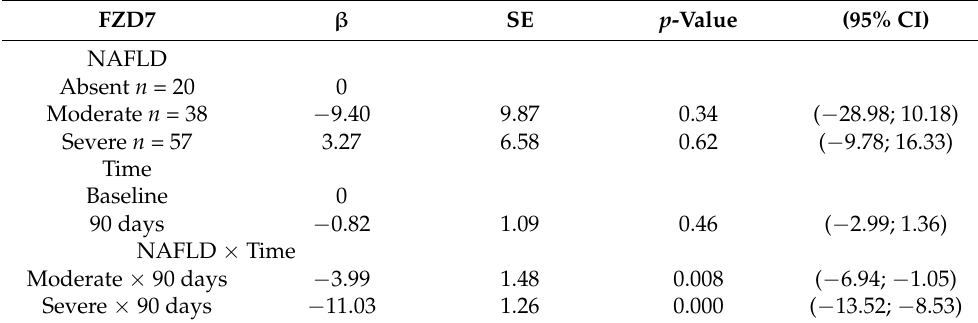
Table 2. Repeated measures analysis of variance. Expected mean FZD7 expression and NAFLD scores (as assessed by CAP value) by time and NAFLD severity. NutriAtt Trial, Castellana Grotte, 2015–2016. Number of healthy subjects (absent) = 20, number of patients affected by moderate steatosis = 38, and severe steatosis = 57.